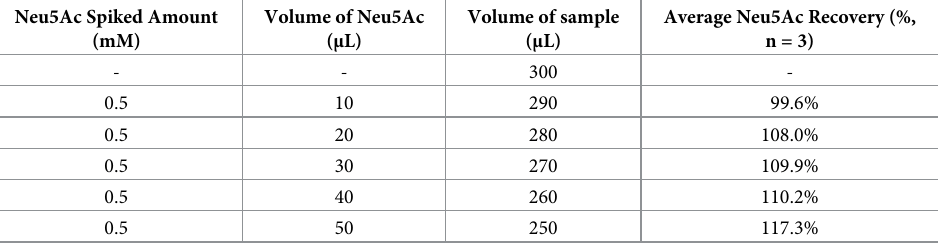
Table 2. Results for accuracy (n = 3) for the proposed method to determine Neu5Ac